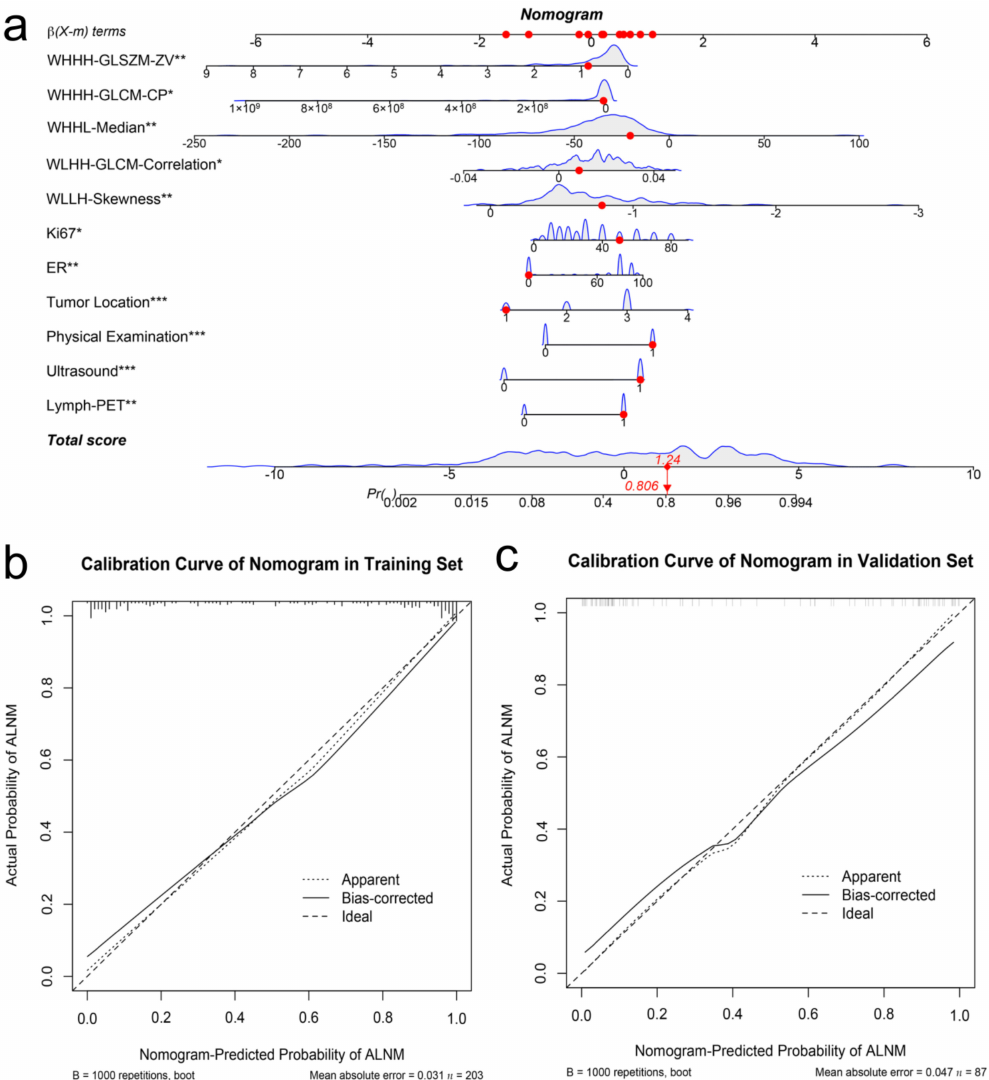
Figure 5. Developed the predict nomogram based on the Combined Model in the training set ( a ). The nomogram presented the ALNM probability of an early-stage breast cancer patients was 0.806, which was confirmed as pN1 stage by surgery. Calibration curves of nomogram in the training set ( b ) and validation set ( c ), respectively. The * represents. p value < 0.05, the ** represents. p value < 0.01, *** represents. p value < 0.001. The X-axis represents the predicted probability of ALNM estimated by nomogram, whereas the Y-axis represents the actual ALNM rates. The solid line represents the ideal reference line that predicted ALN status corresponds to the actual outcome, the short-dashed line represents the apparent prediction of nomogram, and the long-dashed line represents the ideal estimation. Calibration curves show that the actual probability corresponded closely to the prediction of